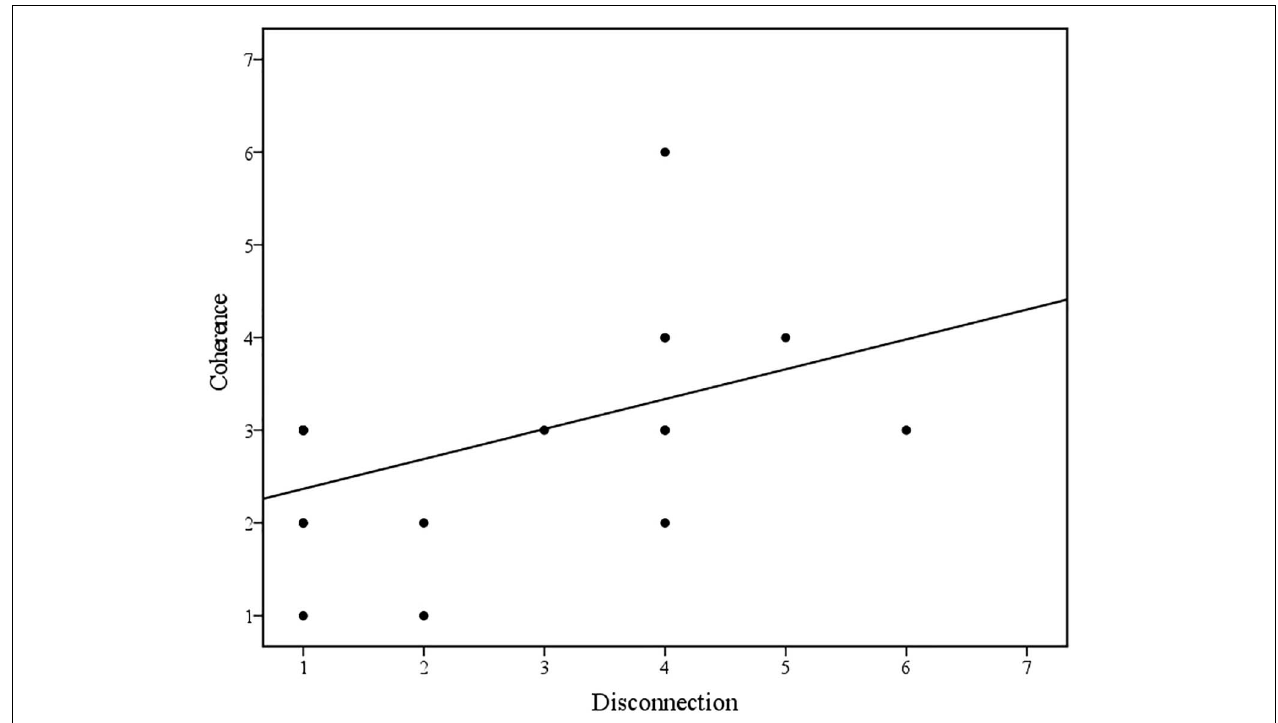
FIGURE 3 | Scatterplot and line of best fit (linear) illustrating the association between Coherence of family discourse and Disconnection ( N = 19) (Linear equation: y = 2.05+0.32 × ; R 2 = 0.22).